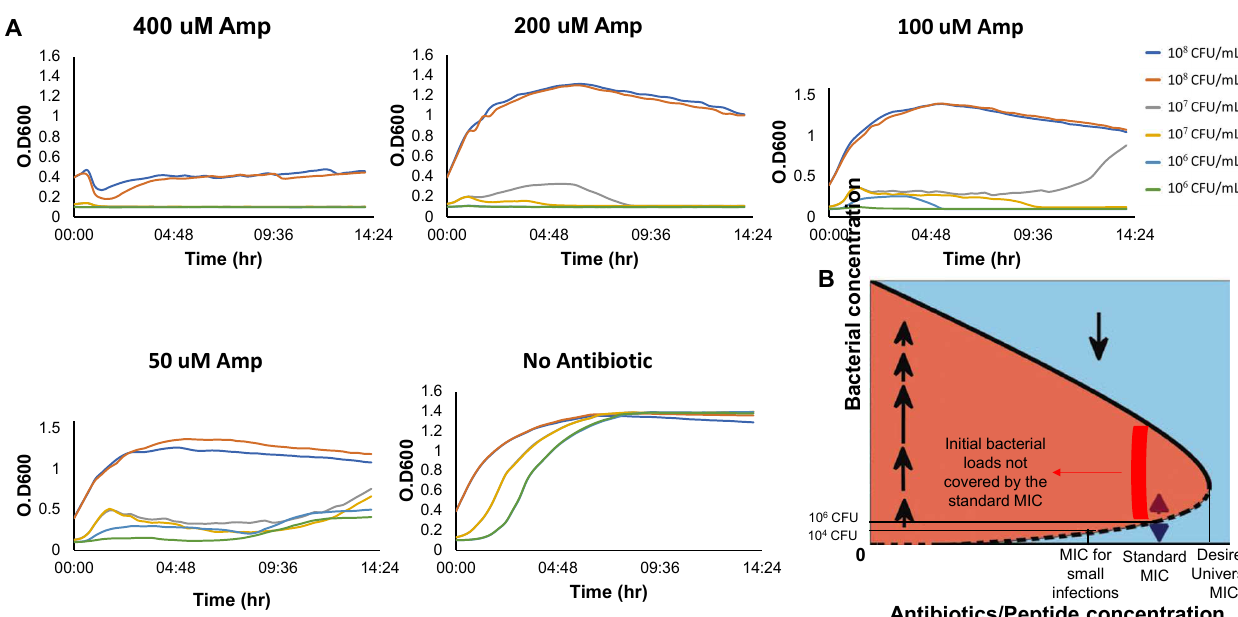
Figure 6. Growth of Inoculums higher than the standard with Ampicillin. ( A ) Growth curves of different initial inocu- lums for 14 h in high concentrations of Ampicillin. ( B ) The standard MIC and its relation to MICs of other inoculums for bistable growth